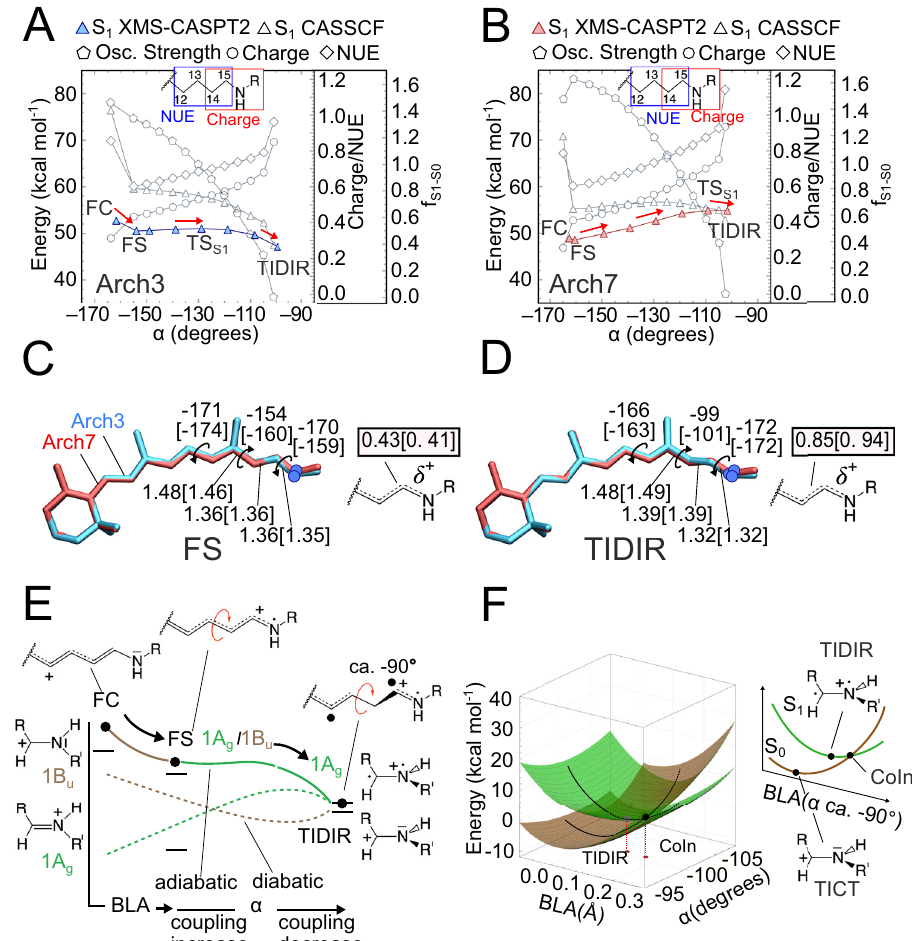
“ decomposition ” of the Arch3 adiabatic energy pro fi le of panel B in terms of dia- batic states associated to Lewis formulas of the CH 2 =NH 2 (+) minimal model. The progression of the electronic and geometrical structure of the relevant moiety of the full chromophore is given at the top. F Schematic representation of the CoIn region of Arch3 including the twisted diradical TIDIR along the relevant compo- nents of the reaction coordinate. The same coordinate also spans the CoIn branching plane. The potential energy scale is relative to the